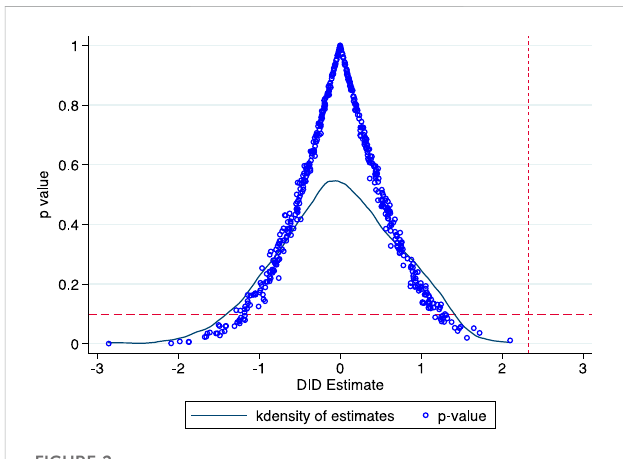
FIGURE 2 Placebo test of the LCCP policy on urban green technology innovation. Notes: The fi gure plots the results of the placebo test. The dependent variable is the natural log of the green patents granted in cities ( G_innov ). All observations are at the city-year level. The estimation model is Eq. 1. The fi gure shows the cumulative distribution density of 500 pseudo-estimations. The vertical line presents the results of columns (2) in Table